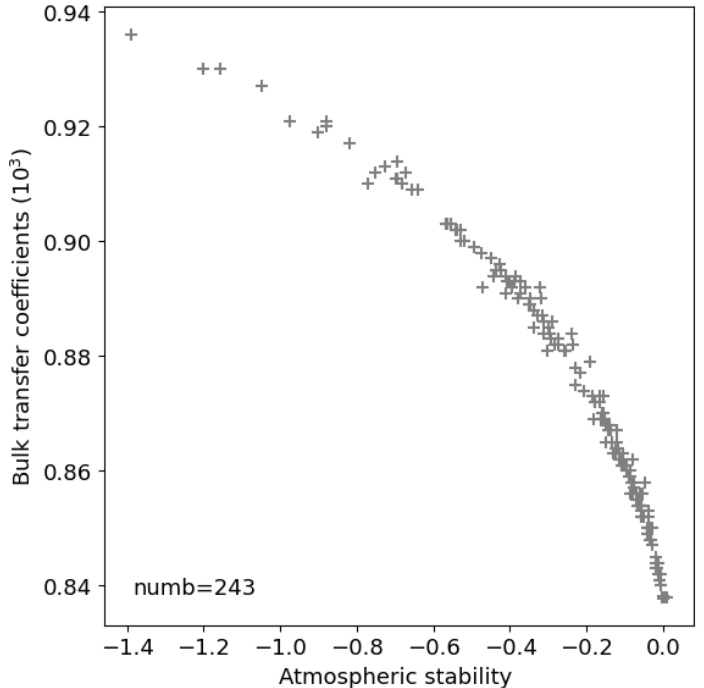
Figure 5. Bulk transfer coefficient C h as a function of atmospheric stability. The dropsonde-based SHF (SHFD) and dropsonde-based LHF (LHFD) were estimated using C h and compared with SHFN and LHFN, respectively. Figure 6 shows a linear relationship between the SHFD and the SHFN, with a correlation coefficient of 0.6, a mean bias of − 3.9 W m − 2 , and a RMSE of 19.3 W m − 2 , which is less than approximately 10% of the maximum SHFN. In the presence of high sensible heat flux, the difference increased, and SHFD exceeded 100 W m − 2 . The comparison of the LHFD and LHFN shows good agreement, with a correlation coefficient of 0.7, a mean bias of 5.0 W m − 2 , and a RMSE of 36.1 W m − 2 , which is less than approximately 10% of the maximum LHFN. We confirmed